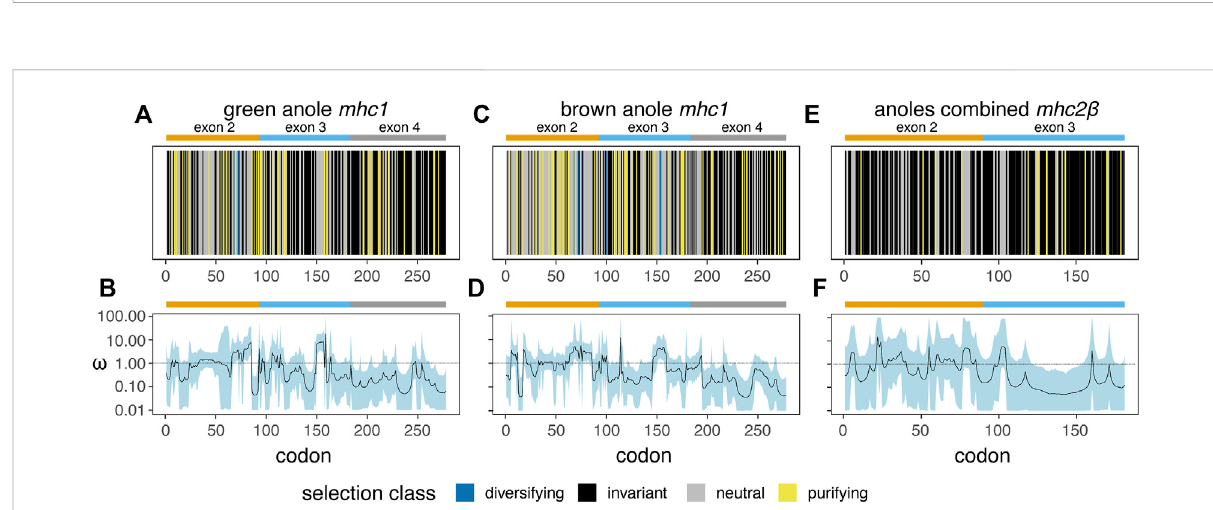
FIGURE 10 Results of two analysis of natural selection - HyPhy Fixed Effects Likelihood (FEL; (A) , (C) , and (E) ) and omegaMap (B) , (D) , and (F) - for mhc1 in the green anole ( A. carolinensis ; (A and B) and the brown anole ( A. sagrei ; (C and D) and for mhc2 β in a combined dataset of both anole species (E and F) . For the FEL analysis (A) , (C) , and (E) , a vertical line represents each codon and is colored based on the inferred codon classi fi cation. The margins and span of exons 2 (orange), 3 (blue), and 4 (grey) are indicated with bars over each panel. See Supplementary Table S14 for the per- codon results of the FEL analysis of each